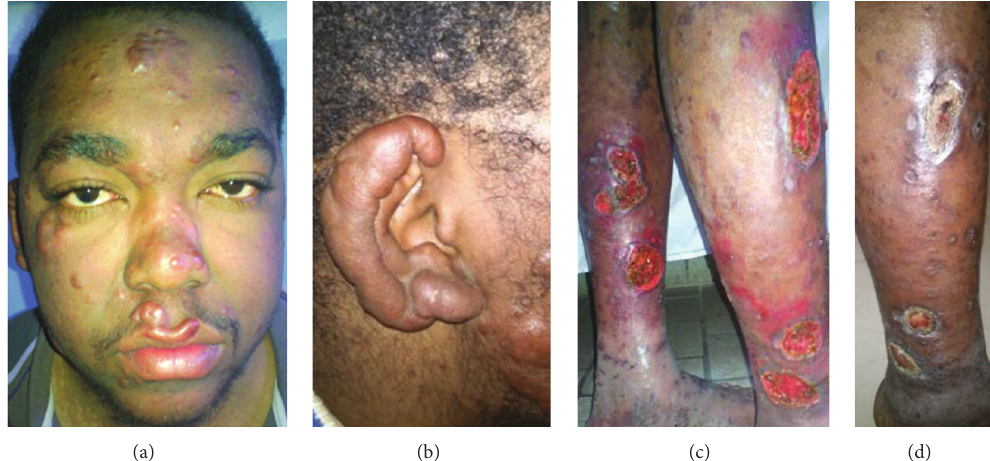
Figure 1: (a) Infiltrated papulonodular lesions on the face. (b) Infiltrated earlobe. (c) Multiple round and oval ulcers on legs. (d) Ulcers with sharply defined borders, margin erythema, and septic, purulent